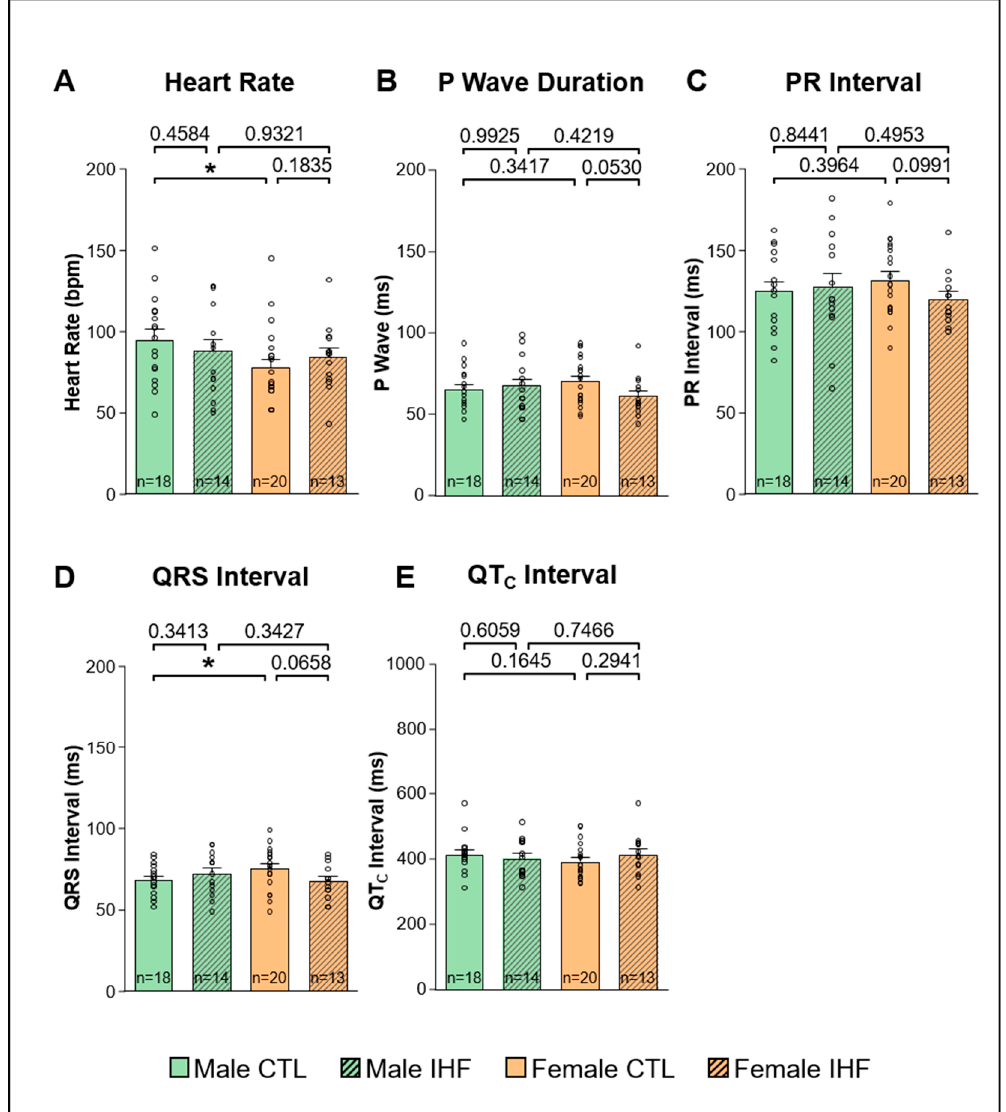
Figure 3. ECG parameters. ( A ), Heart Rate. ( B ), P Wave Duration. ( C ), PR Interval. ( D ), QRS Interval. ( E ), Corrected QT Interval (calculated according to Bazett). CTL , control animals without ischemic heart failure; IHF , animals with ischemic heart failure. Bar graphs represent Mean + SEM, grey circles represent data of individual pigs. Mann-Whitney-U Test. * p < 0.05.